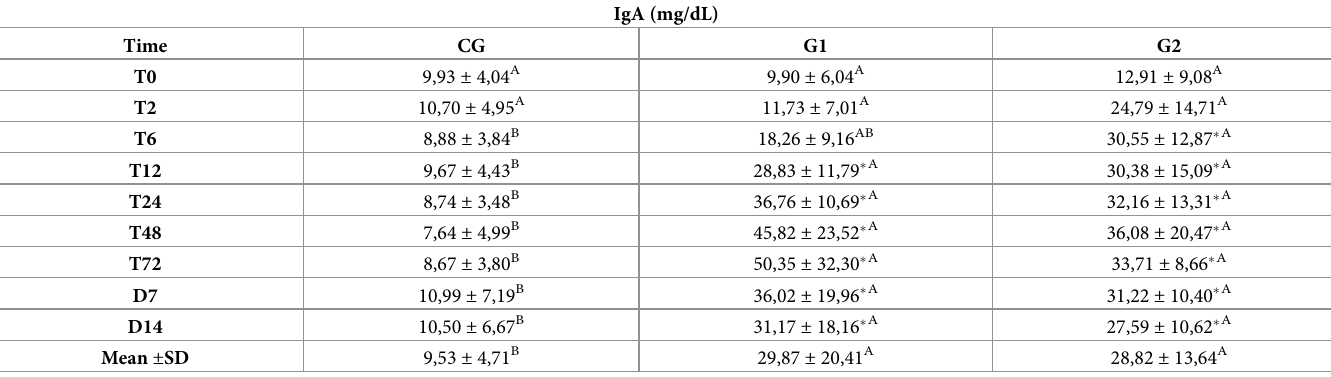
Table 10. Mean and standard deviation (SD) of IgA in the peritoneal fluid of healthy horses (CG) and horses submitted to cecal trocarization with a cecal needle (G1) or a cattle trocar (G2).